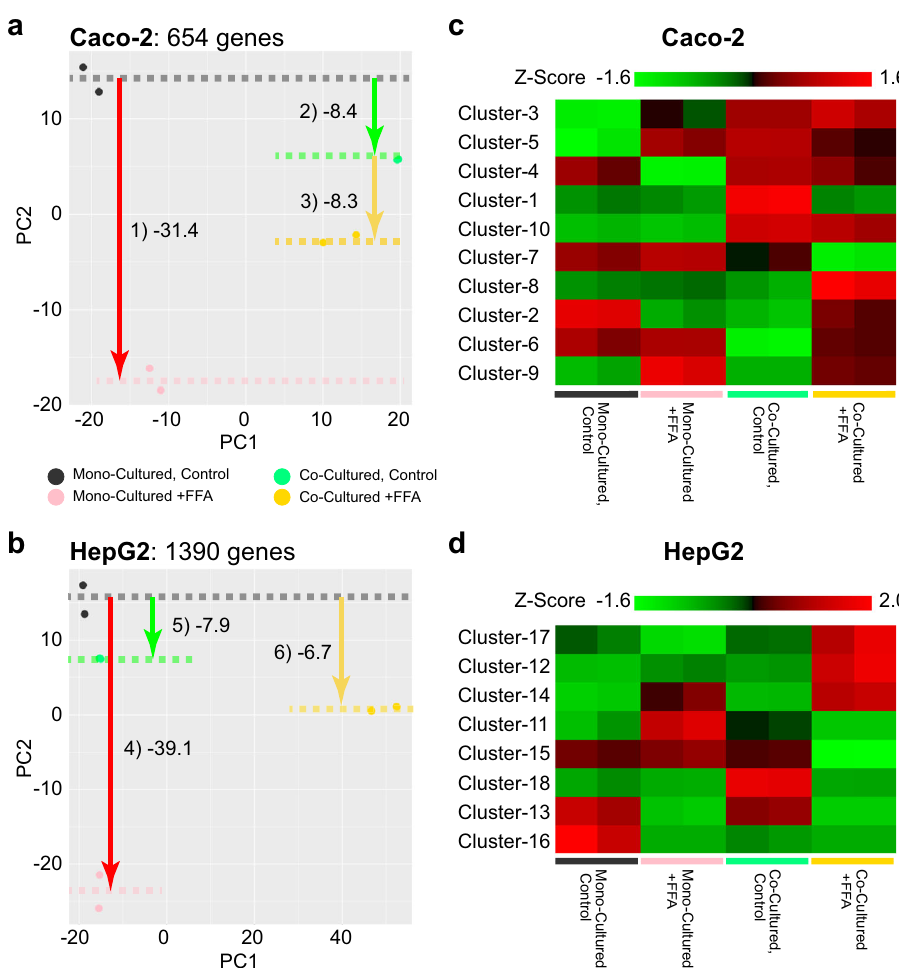
Fig. 6 Gene expressions of the effects of FFAs treatment for 7 days and crosstalk with the in vitro human GLA model. a , b PCA results for DEGs obtained from the Caco-2 ( a ) and HepG2 ( b ) experimental sets. The mean PC2 values among the replicates are shown with dotted lines. For these diagrams, the gene name and change direction shown in ( a , b ) were considered. c , d Heat maps for the DEGs. Z -values of the expression pro fi les are FFAs-treated Caco-2 cells co-cultured with HepG2 cells had pro- tective effects against lipid-induced apoptosis (8.2 ± 7.2%), and similar levels were observed in non-treated Caco-2 cells (mono- cultured,